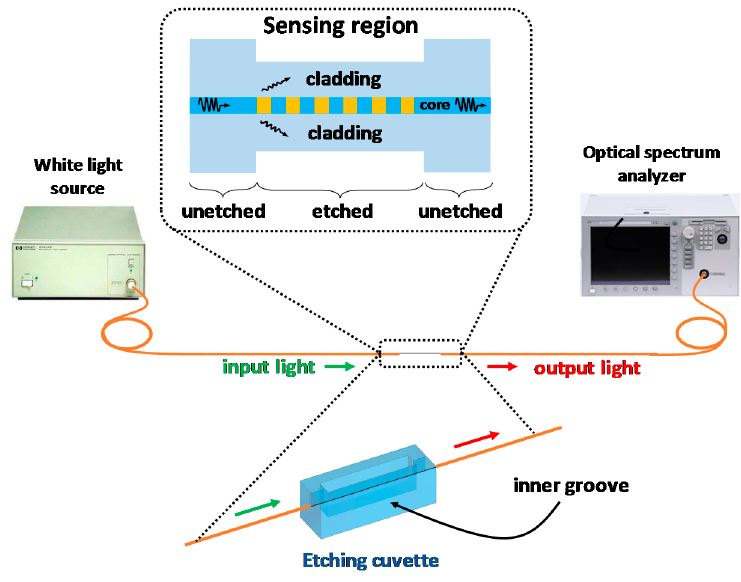
Figure 1. Experimental setup.